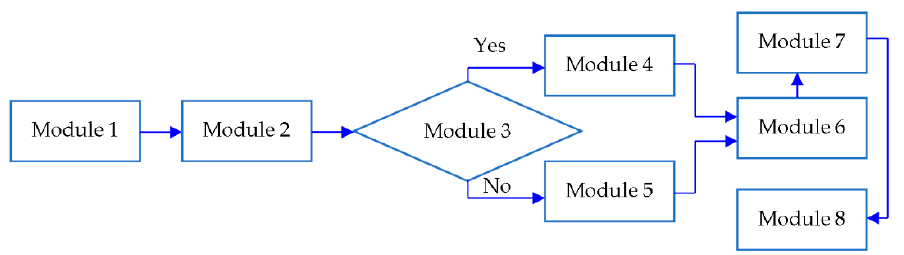
Figure 19. General algorithm of spline curve formation.